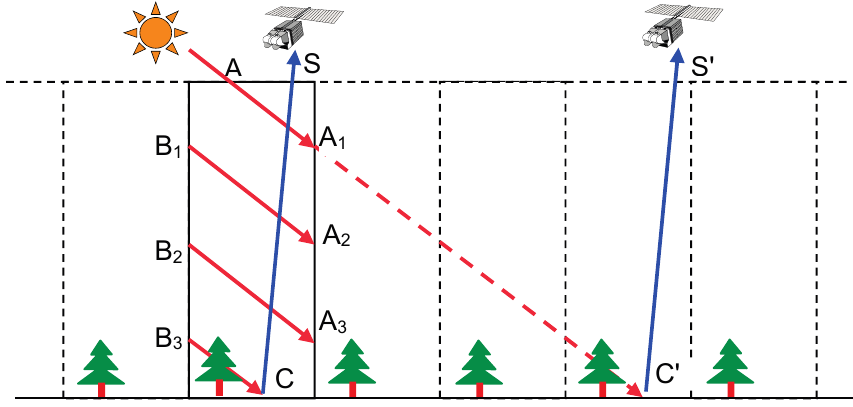
Figure 4. Simulation of a flat infinite repetitive